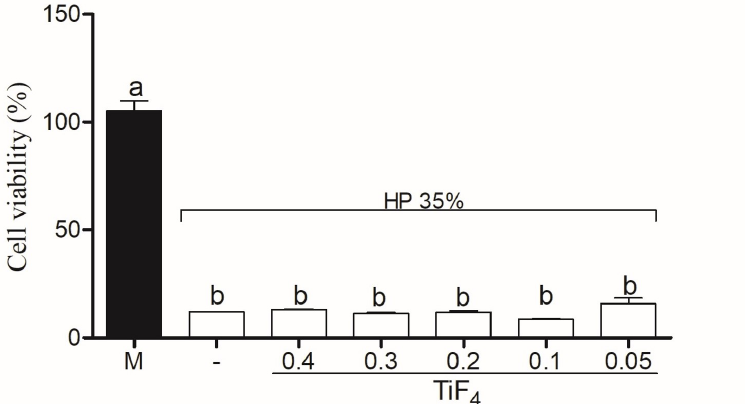
Figure 6. Cell viability of control group (HP) and treatment groups combined with HP. Legend: Means followed by different letters indicate statistical differences according to one-way ANOVA with Tukey post hoc test with significant level set at 5%. M: medium; HP: hydrogen peroxide; TiF 4 : titanium